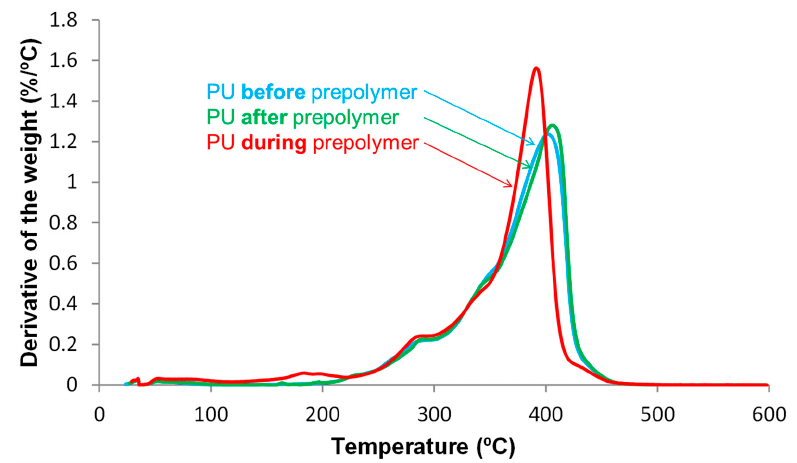
Figure 13. Variation of the derivative of the weight as a function of the temperature for PU films. DTGA experiments. Table 5. Temperatures and weight losses of the thermal decompositions of the PU films. DTGA experiments.